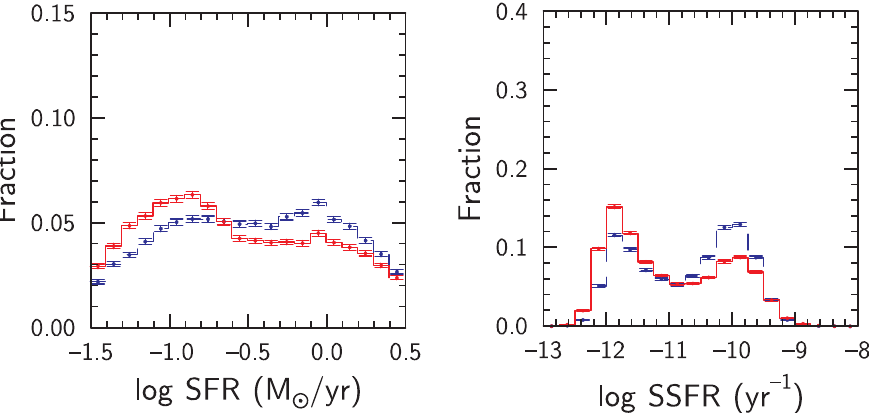
Fig. 1. SFR and SSFR distributions for the pair (red solid line) and the control (blue broken line) samples. The error bars are 1 (cid:27) Poissonian errors. Designations are the same in Figures 2–6.